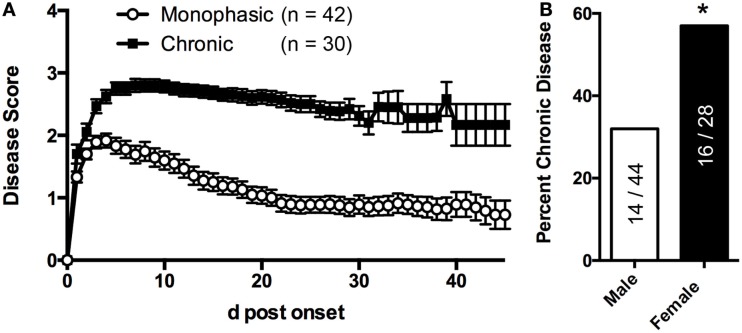
sEAE in 2D2 IgHMOG mice can follow a monophasic or chronic disease course. (A) 2D2 IgHMOG mice were allowed to develop CNS autoimmune disease and severity was evaluated daily. Mice that developed signs of CNS autoimmune disease for at least 21 days (excluding mice that had been used experimentally or were euthanized prior to 21 days) were divided into “monophasic” or “chronic” categories based on the following criteria: chronic – no more than 1 point recovery after the acute phase as determined by the standard 5 point score system. Monophasic – recovery of at least 1 point on the severity scale and a final score <2. (B) Compared to male mice, a greater proportion of female mice develop chronic disease as determined by Chi-square analysis (p = 0.0004, df 12.65,1).